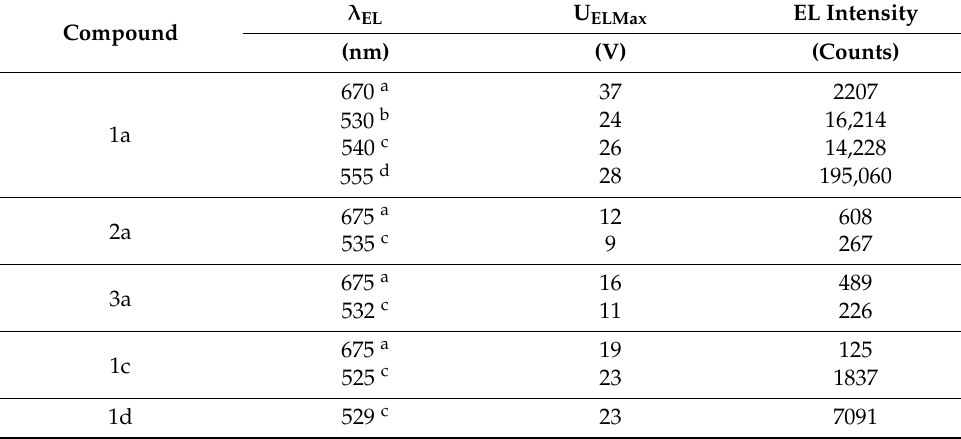
Table 5. The electroluminescence data of prepared diodes.